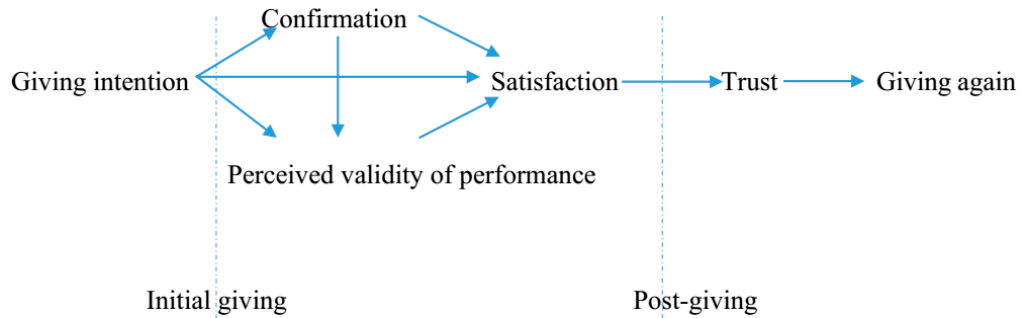
Figure 1. Repeat giving decision of an individual INGO Donor. Source: Adapted (with permission) from ([71], p. 9).